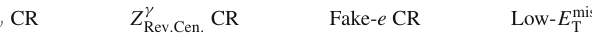
Table 3 Summary of the requirements defining the baseline SR and various CRs considered in this analysis. Where present, the values in squarebracketsrefertotheregionsdefinedinthesearchfora H → γγ d signal. The leading and subleading jets must satisfy the fJVT require- ments mentioned in Sect. 5. In the SR, Z